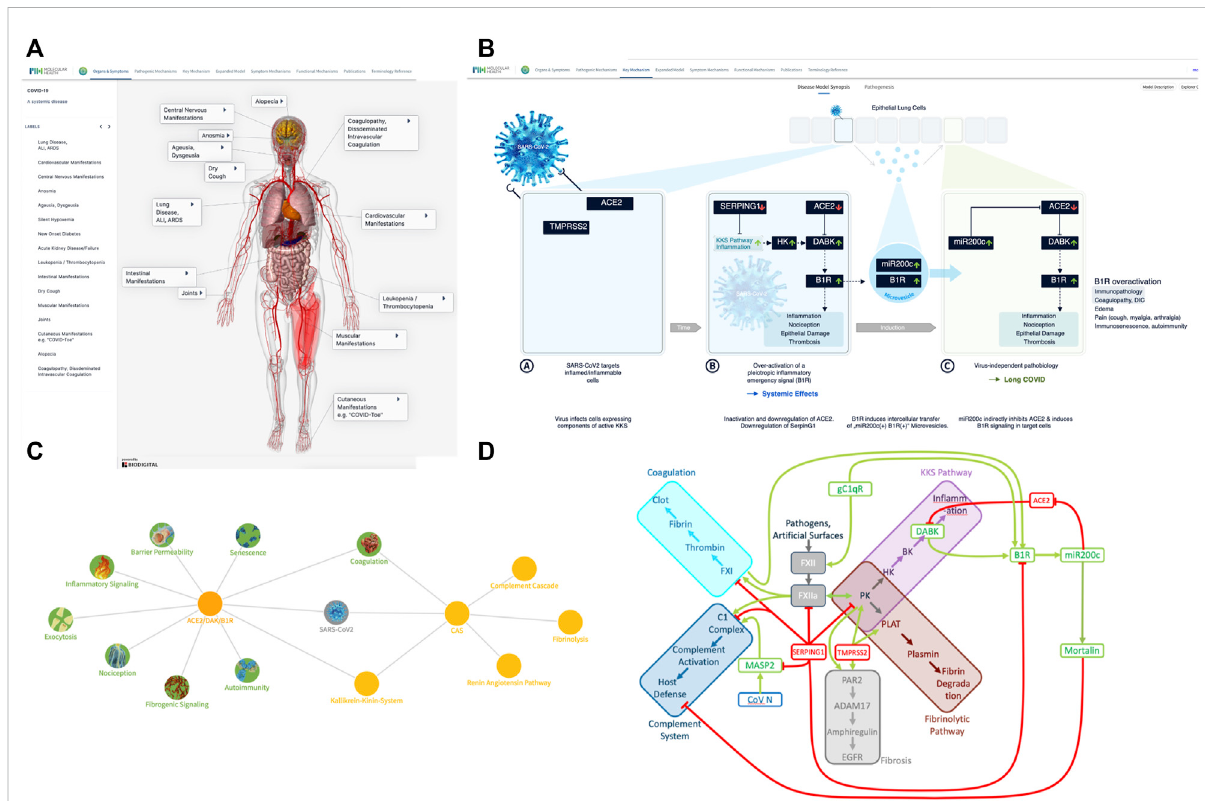
FIGURE 1 COVID-19 diseasemodel — fromsymptomatology tomolecularmechanisms. (A) The manyfacesofCOVID-19 — asystemicdisease: COVID-19 comes with diverse clinical manifestations affecting a broad range of organ systems. Originally identi fi ed as respiratory disease (Huang et al., 2020) (pneumonia, acute respiratory distress syndrome (ARDS), Acute Lung Injury (ALI), shortness of breath, cough) with highly viscous mucus (Wu et al., 2020;Zhuetal.,2020),manymoremanifestationsandaffectedorganswerereportedovertime.Theseincludeneurologicmanifestations(Mao R. et al., 2020; Ellul et al., 2020)and silent hypoxemia (Couzin-Frankel, 2020), musculoskeletal manifestations (Cipollaro et al., 2020), gastroenterological symptoms (Barrera et al., 2020; Mao Y. et al., 2020), cardiovascular manifestations (Kang et al., 2020; Zheng et al., 2020), endotheliitis (Varga et al., 2020), coagulopathy (Levi et al., 2020), new onset diabetes (Rubino et al., 2020), kidney injury (Selby et al., 2020), leukopenia (Ruan et al., 2020). VisualizationwasrealizedusingtheBiodigital3Danatomymodel(www.biodigital.com). (B) SynopsisofthebasicCOVID-19 DiseaseModel. (B) (sub-panel A)Thevirustargetshostcellsexpressing ACE2andTMPRSS2, activecomponentsof theKKS. (B) (sub-panel B)Withinthecell thevirusinducesdownregulationofSERPING1andACE2.SERPING1downregulationinducesactivationoftheCASandKKS.ACE2downregulationresultsin accumulationofDAKs.ExcessDAKsactivateB1R,triggeringaconstitutiveactivationandauto-ampli fi cation.UndernormalconditionsB1Ractivationtriggers a fast, transient in fl ammatory emergency reaction inducing neutrophil and leukocyte recruitment and in fi ltration, opening of the epithelial/endothelial barriers for their transmigration, coagulation for local walling-off, fi brogenesis for wound healing, senescence as host defense mechanism and transient nociception.Constitutiveactivationofthissystemleadstoexcessin fl ammatorysignaling,epithelial/endothelialbarrierbreakdown,inductionofthrombosis, fi brosis,painandothereffects. (B) (sub-panelC)B1RsignalinginducestheformationofMVsbearingB1RandmiR200c.Thesearetransferredtotargetcells, inducingfurtherexpressionofmiR200c,whichleadstoACE2downregulationandformationofexcessDAKswhichsignal via B1R.Thus,MVtransfer via auto- activation and ampli fi cation of the B1R system may trigger the virus independent propagation of an in fl ammatory phenotype. (C) COVID-19 clinical phenotypesassociatedto eightkey pathogenicmechanisms. Keymechanisms (green)andassociatedsigns, symptoms andsyndromesof COVID-19(blue) induced by over-activation of the ACE2/DAK/B1R signaling axis. Members of the axis, as well as regulatory elements (e.g., miR200c, SIRT1, EZH2, etc.) convergeatthese mechanismsand complement eachother to variousdegrees ininducing the corresponding phenotypes. (D) Thekey playersof the seed modelconvergeattheCAS,ContactActivationSystem.CASconstitutesagroupofplasmaproteinsthatareactivatedbyFXII.FXIIactivatesproin fl ammatory, procoagulant and host defense pathways. The initial step involves activation of PK, prekallikrein. PK reciprocally activatesFXII. In fl ammation resultsfrom the activation of the KKS, Kallikrein Kinin system resulting in the release of kinins, BK, bradykinin and KD, Kallidin, and the DAK, des-Arg-Kinins DABK and DAKD from high molecular weight kininogen (HK). Coagulation is driven by FXIIa-mediated cleavage of FXI, which eventually leads to thrombin activation and clotting.FXIIactivationalsoleadstoincreasedplasminactivation,whichbreaksdownthe fi brinclot.Finally,FXIIcanactivateC1randC1softhecomplement pathway. SERPING1 is the key regulator of CAS activation. It is the main inhibitor of the FXIIa, the C1 complex and the conversion of HK to kinins. TMPRSS2 activates tissue kallikrein KLK2, PLAT and fi brinogenic PAR2, which can also be activated by KK. ACE2 metabolizes DAK, thus inhibiting DAK signaling. DAK activates and induces expression of B1R. gC1qR, a pathogen receptor and key activator of the CAS, induces the expression of B1R. B1R activation in turn induces miR200c, which directly targets and suppresses ACE2, constituting a feed-forward loop leading to the generation of excess DAK. miR200c induces Mortalin an inhibitor of the cytotoxic component of the complement cascade. Complement activator MASP2 is a target of the virus N protein. SERPING1 inhibits MASP2 proteolytic